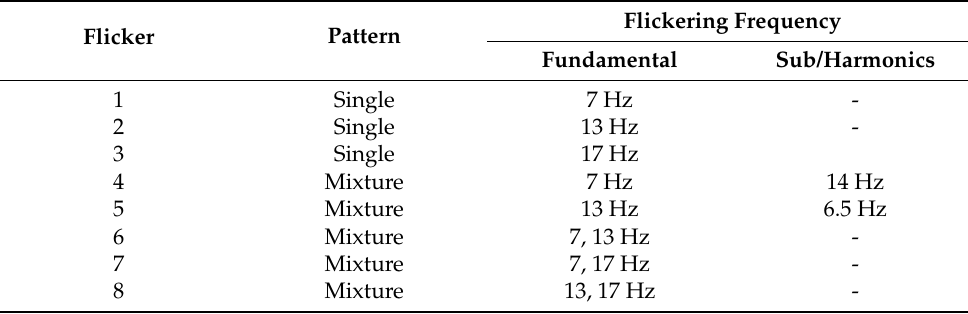
Table 2. Proposed flickering frequencies and patterns of SSVEP stimulus. Flickering Frequency Flicker Pattern Fundamental Sub/Harmonics 1 Single 7 Hz - 2 Single 13 Hz